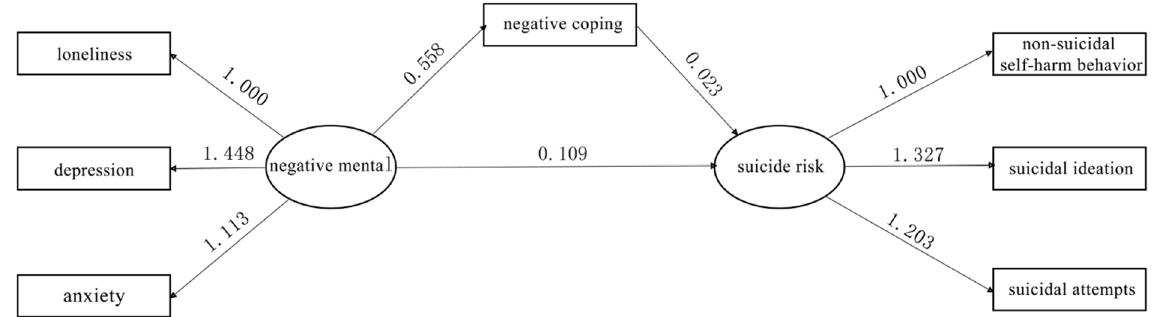
Figure 1. Path model of the relationships between negative mental, negative coping style and suicide risk.